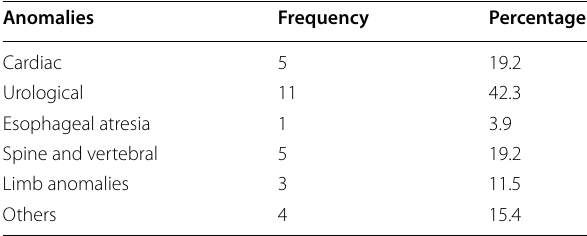
Table 1 VACTRAL associations among the study